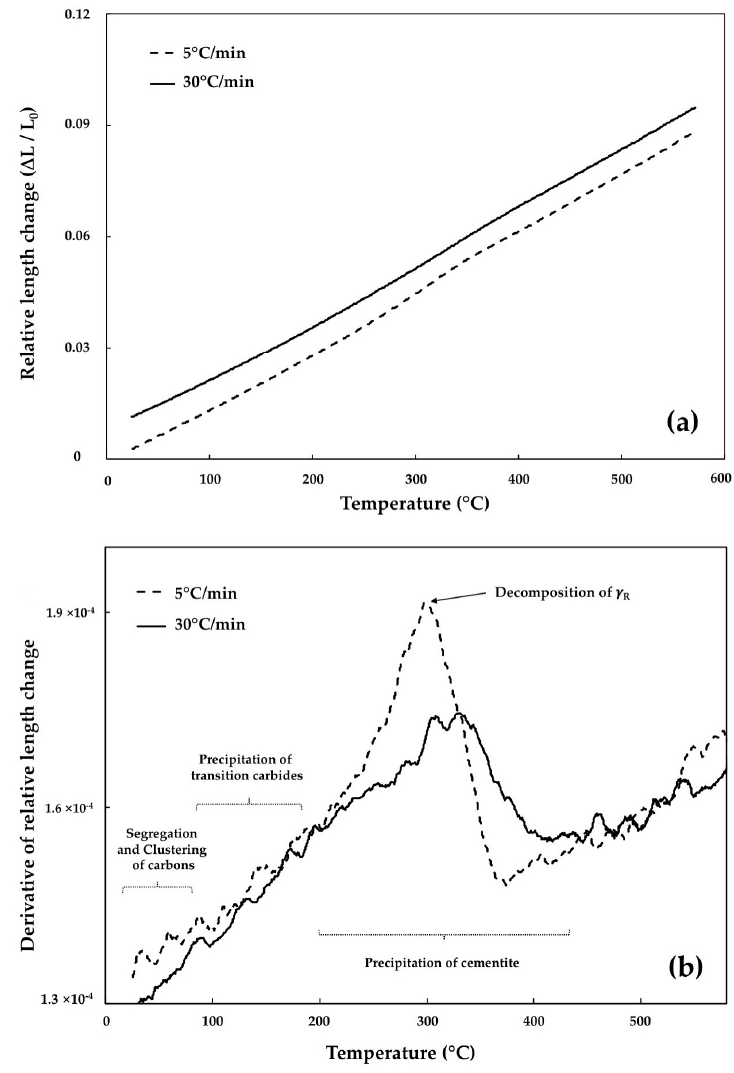
Figure 3. ( a ) Relative length change diagram during non-isothermal tempering of bainitic specimen at heating rates of 5 °C/min and 30 °C/min, and ( b ) the first derivative curve of the relative length change corresponding to these heating rates.